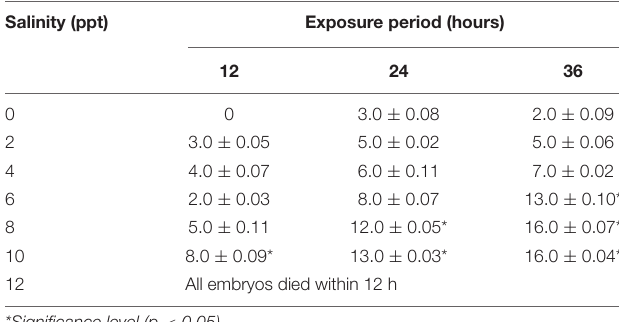
TABLE 2 | Percent (%) abnormalities of the embryo of striped catfish in different salinities ( n = 150 embryos). Salinity (ppt) Exposure period (hours)